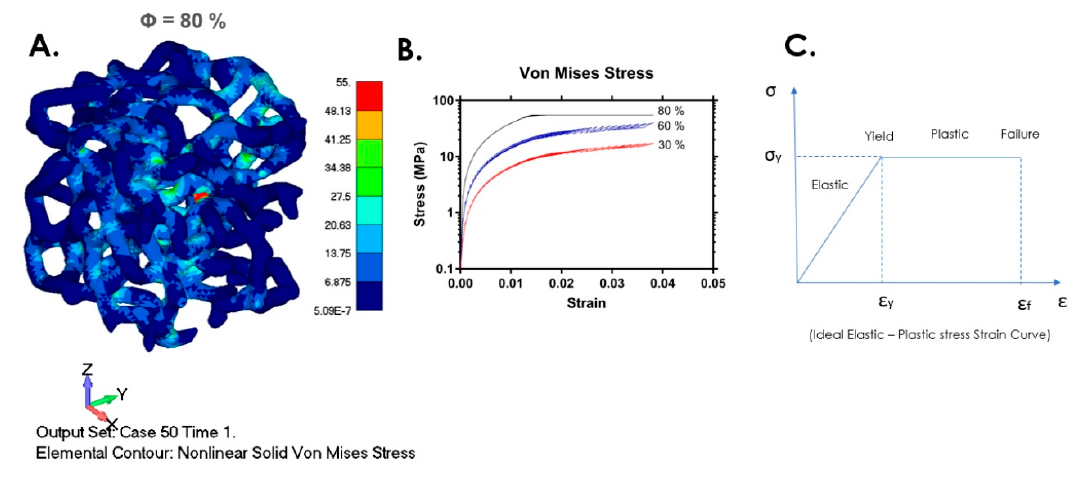
Figure 4. ( A ) Von Mises stress contour, sample with 80% porosity; ( B ) stress–strain curve, log form; ( C ) ideal elastic–plastic stress–strain curve.